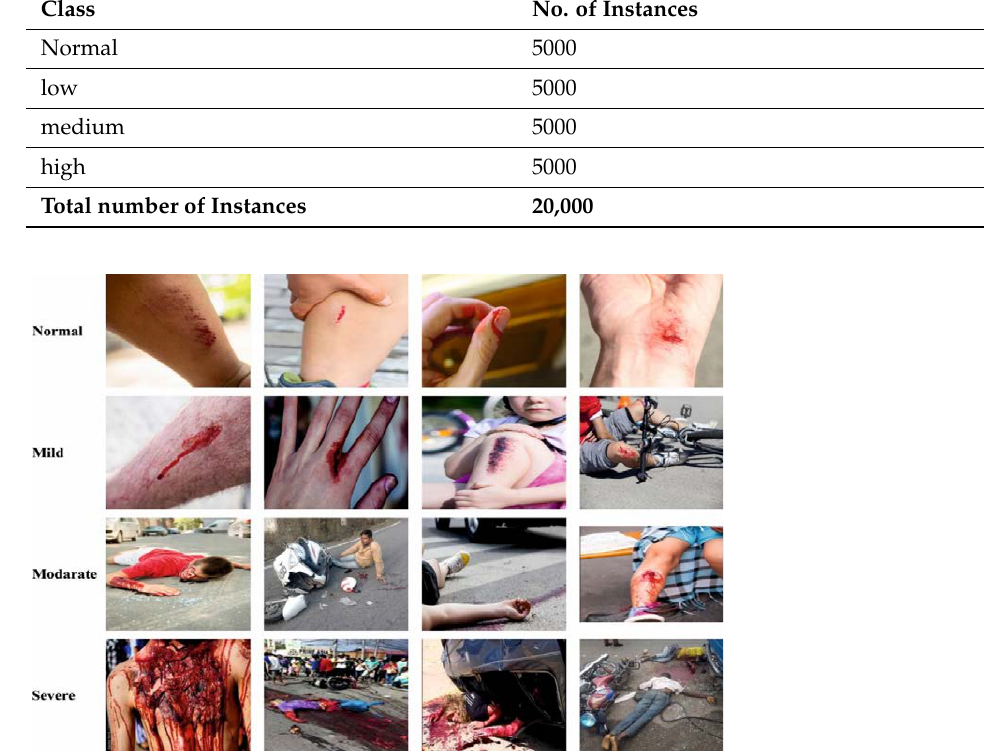
Table 2. Result analysis of the PPIE-ODLASC system with various images.